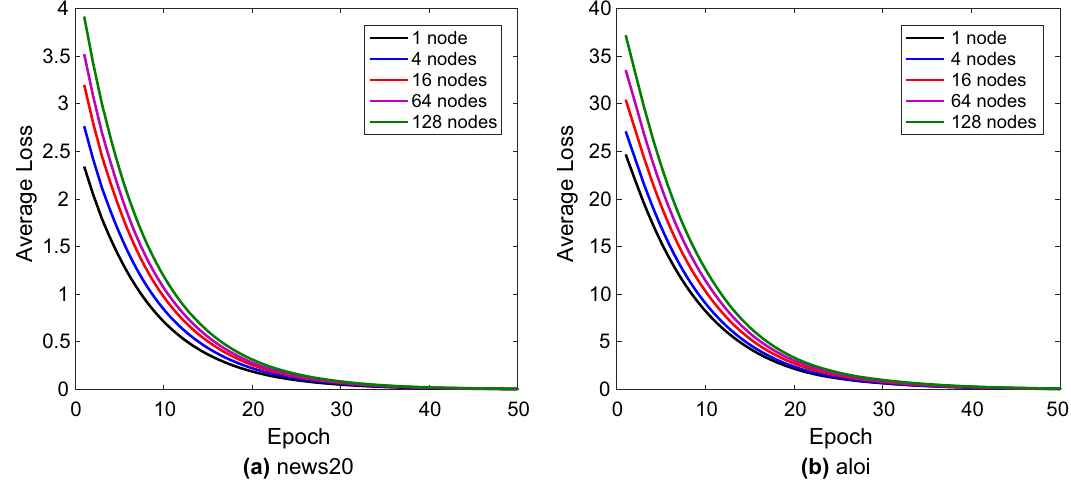
Fig. 2 Comparison of the proposed algorithm with varying number of nodes on news20 and aloi datasets